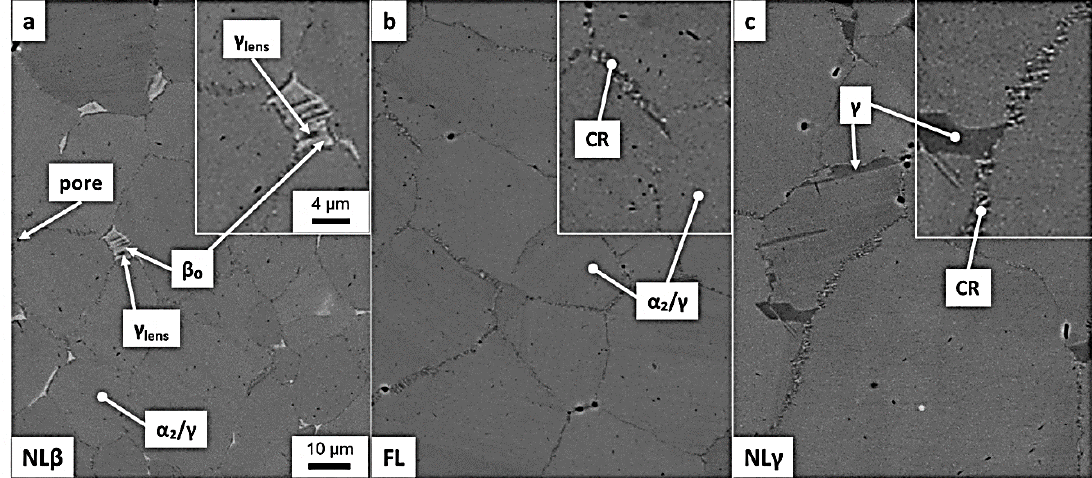
Figure 15. SEM images showing ( a ) NL beta ( β ); ( b ) fully lamella (FL); and ( c ) NL gamma ( γ )microstructures after two-step heat treatment [141].